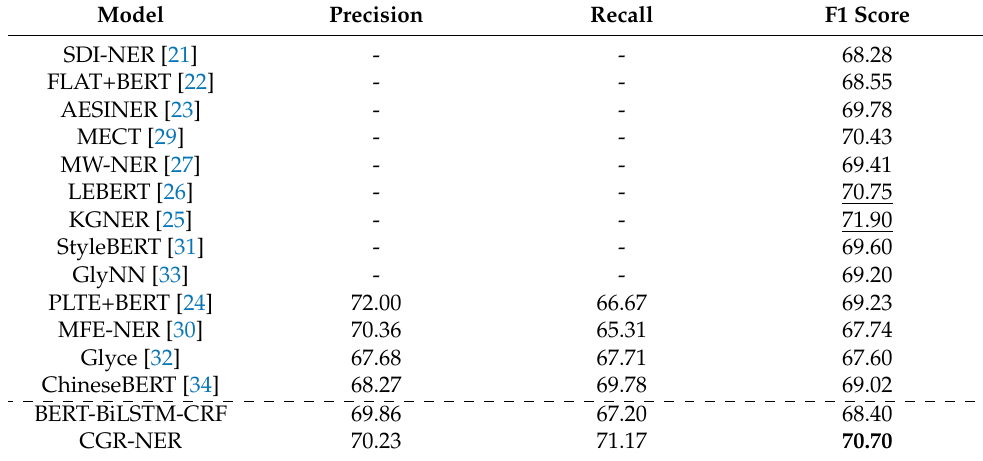
Table 6. Results on Weibo